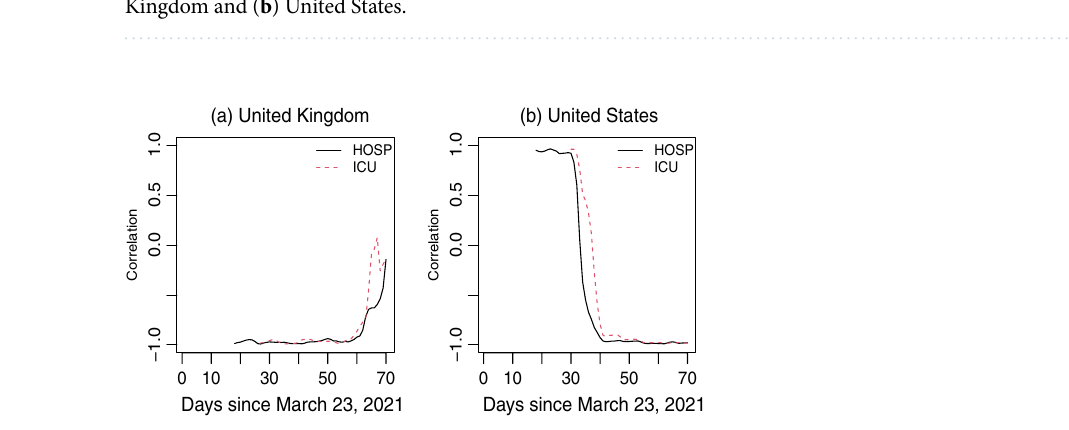
Figure 4. Dynamic correlation of hospitalization per million and ICU patients per million with lagged vaccination rates in ( a ) United Kingdom and ( b ) United